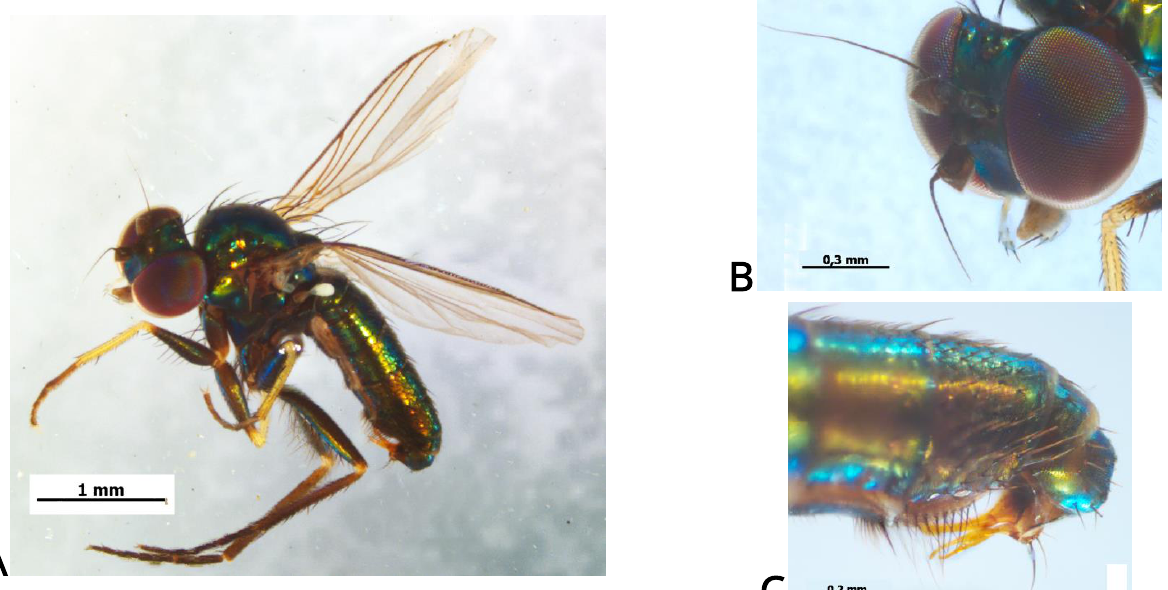
Figs. 4. Asyndetus chaetifemoratus Parent, 1925: A-male habitus; B-head; C-hypopygium.